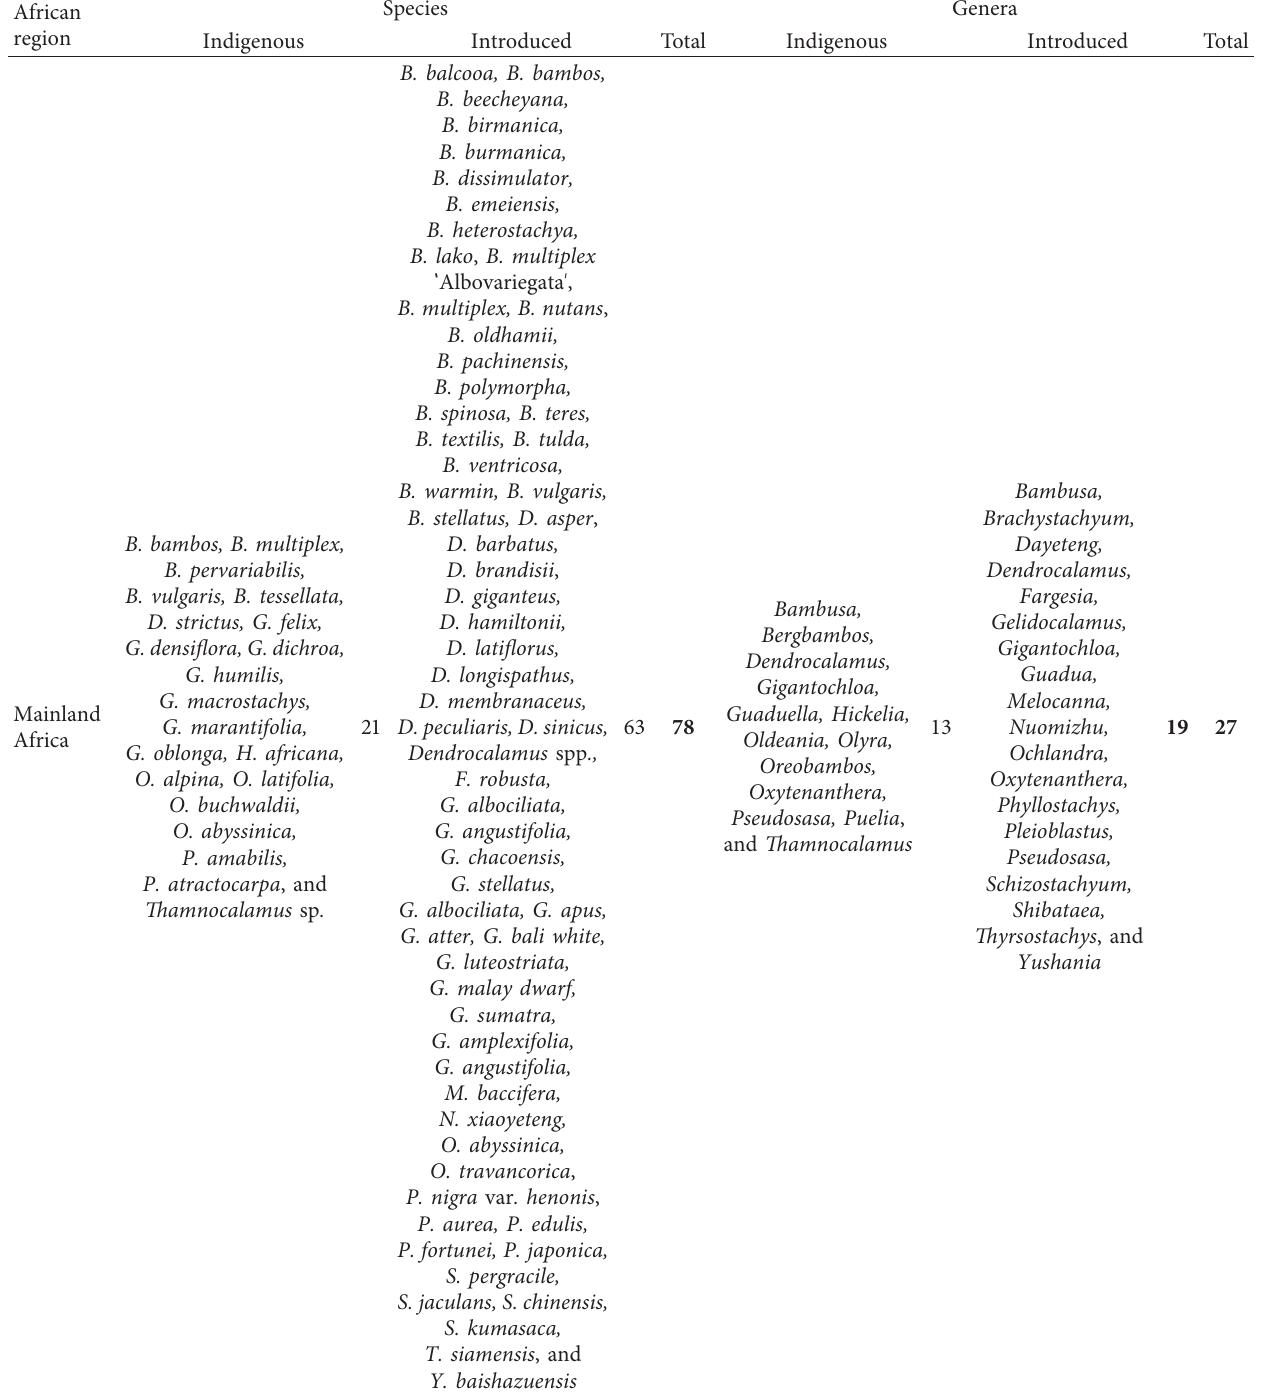
Table 4: A summary of bamboo resource diversity and distribution in the African